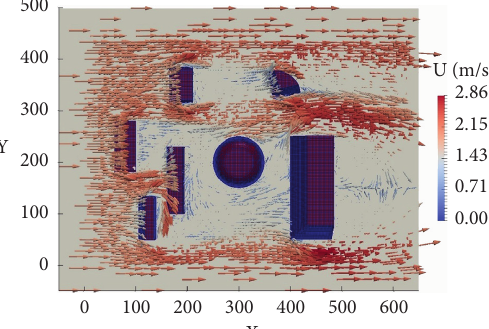
Figure 2: Detailed flow field around the reefs (velocity vectors 15m above seafloor).